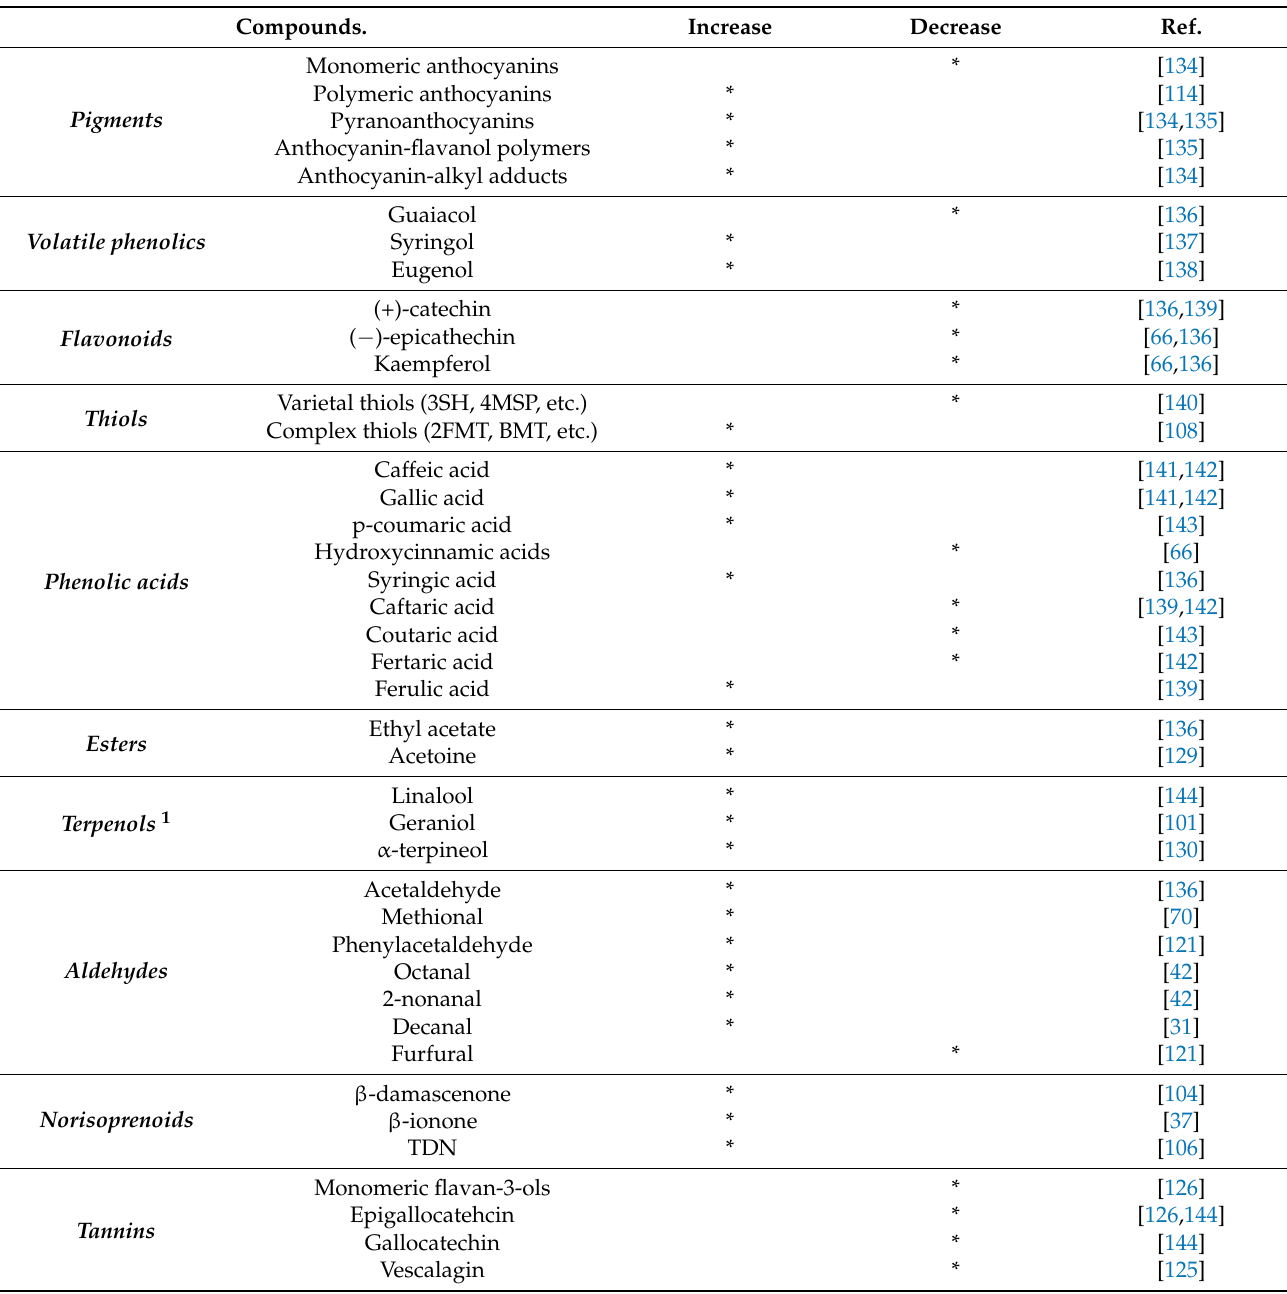
Table 3. General tendency of increasing and decreasing relevant compounds during bottle aging. Compounds.